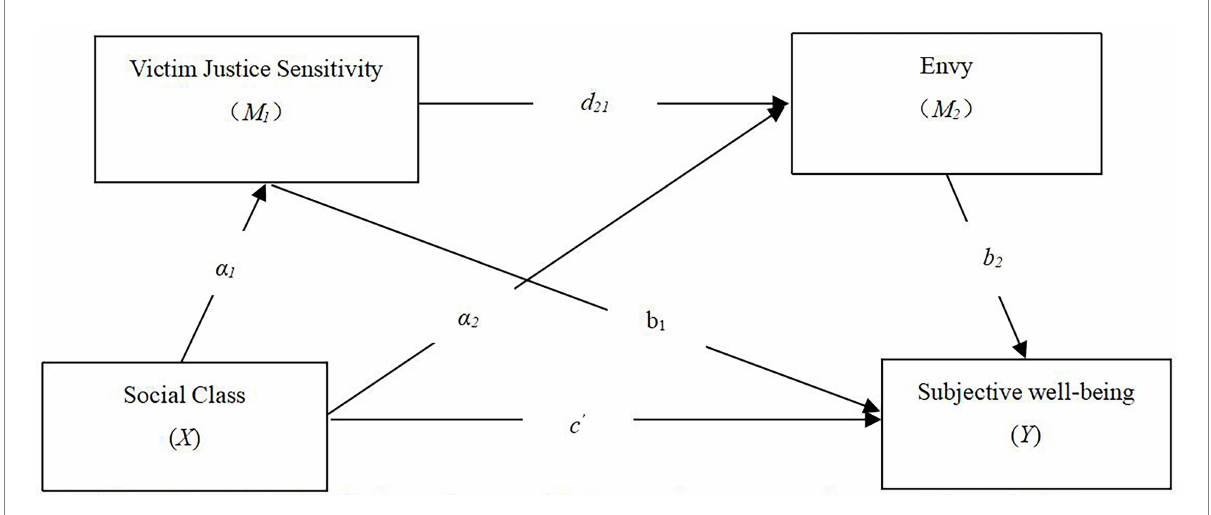
FIGURE 1 A hypothesized serial multiple mediation model. Age and gender were considered as control variables. * p < 0.05, ** p < 0.01, *** p <